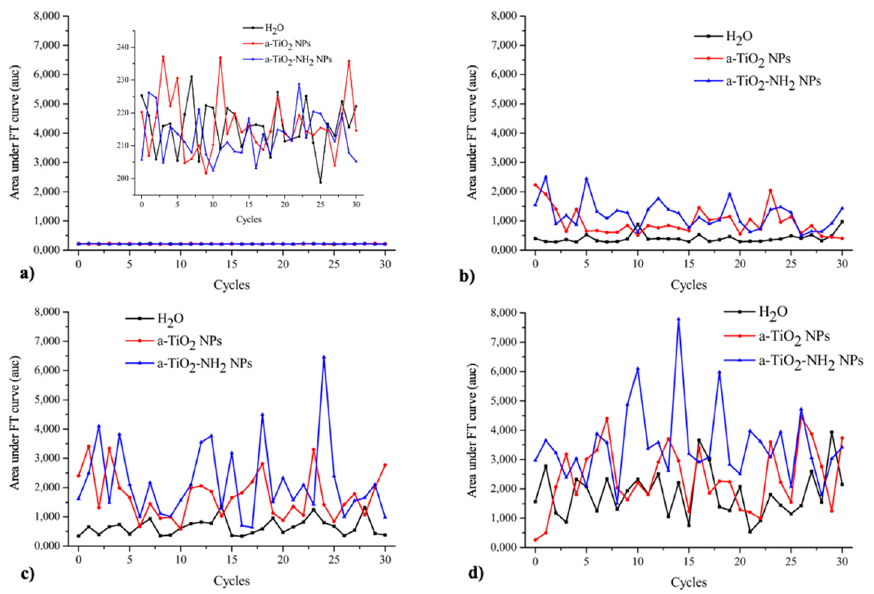
Figure 8. Area under the FT curve computed from the signal recorded through a focused piezo-detector used as cavitometer to analyze the cavitation of water and a-TiO 2 based NPs suspensions. The analysis were made using the following conditions: 1 MHz, 100% of DC, 1 min of irradiation with ( a ) 0.3 W / cm 2 of US output power; ( b ) 0.6 W / cm 2 of US output power; ( c ) 0.9 W / cm 2 of US output power; ( d ) 1.2 W / cm 2 output power.